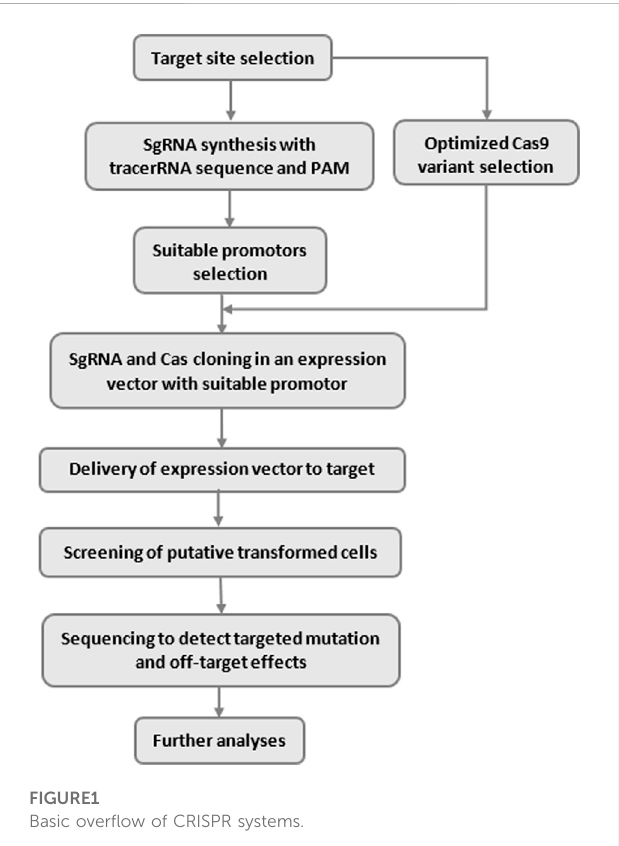
FIGURE1 Basic over fl ow of CRISPR